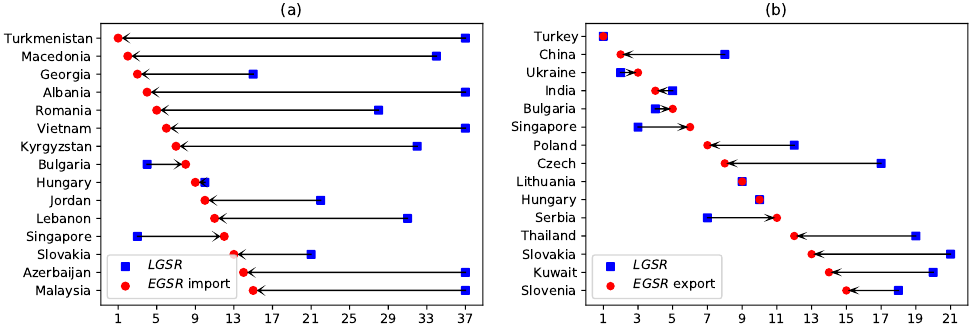
Figure 5. Change of rankings from LGSR s to EGSR for the top 15 countries with the highest EGSR . ( a ) from LGSR s to EGSR imports; ( b ) from LGSR s to EGSR